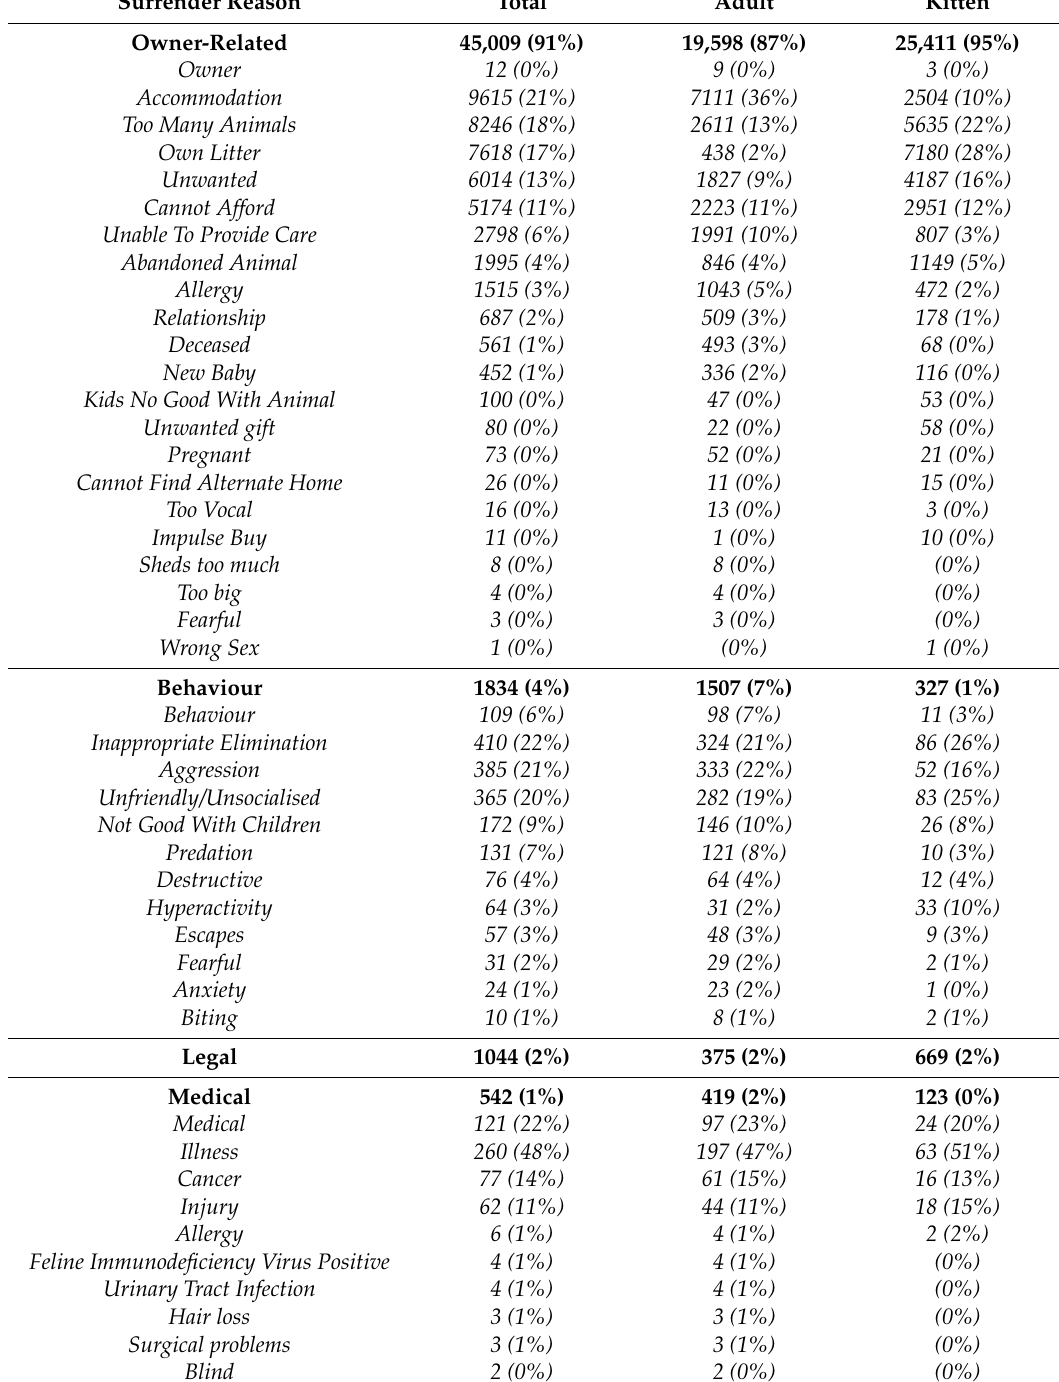
Table 6. Distribution of owner-surrendered admissions to 39 RSPCA shelters between June 2006 and July 2010 by age category and surrender reason. Only the 49,393 owner-surrendered admissions where a reason for surrender was provided are included. Within each column, italicised percentages sum to 100% within each surrender reason